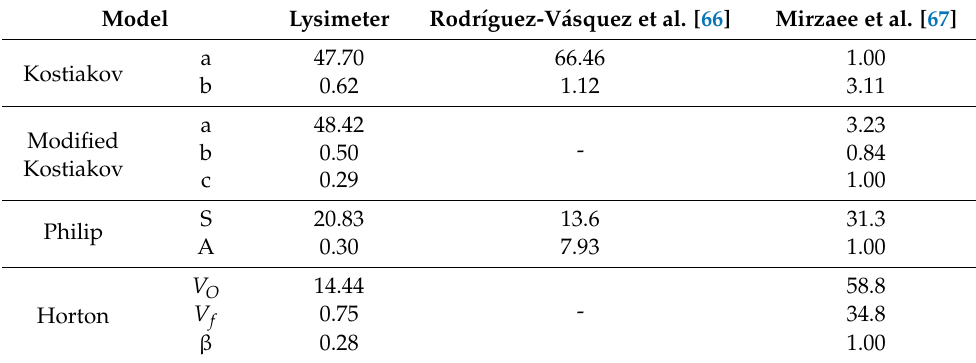
Table 5. Parameters values of infiltration models for silt loam